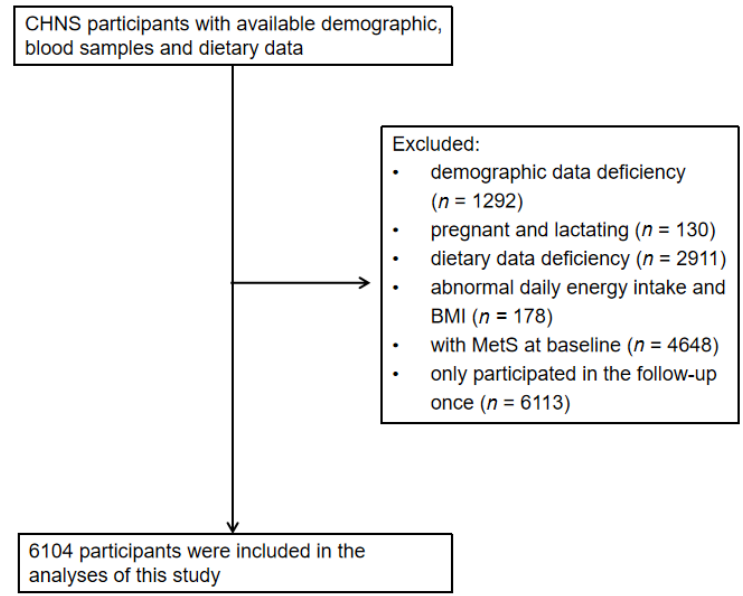
Figure 1. Flowchart of subjects.